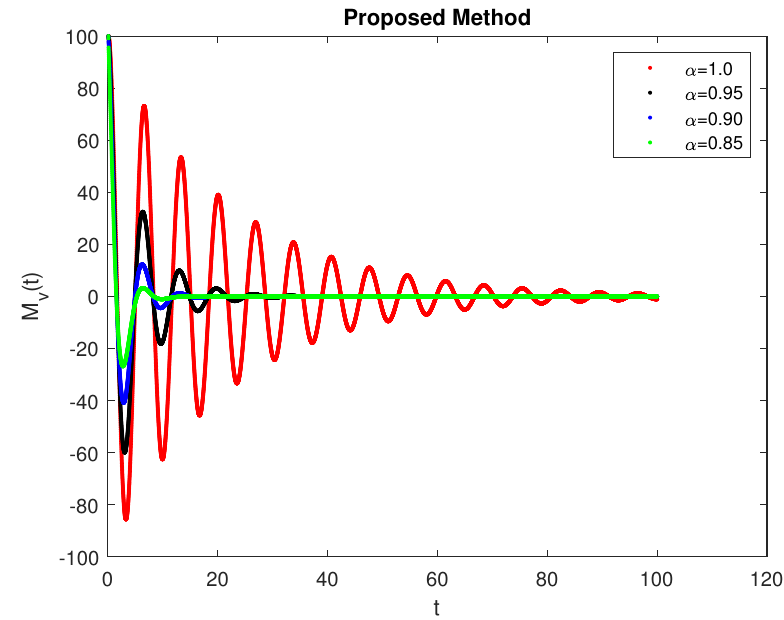
Figure 5: Numerical simulations for τ = 0.98 for ABC derivative.